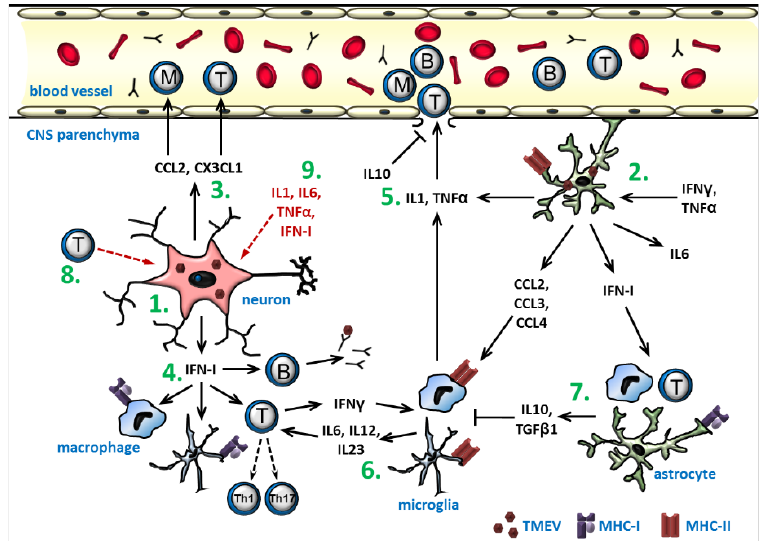
Figure 7. A schematic overview of the cytokine- and chemokine-mediated effects during early inflammation in a Theiler’s murine encephalomyelitis virus infection: ( 1 ) TMEV-infection of neurons results in the expression of chemokines and IFN-I. ( 2 ) Virus replication in astrocytes and their stimulation by IFNγ and TNFα also causes cytokine and chemokine production. ( 3 ) The chemokines CCL2 and CX3CL1 attract monocytes and lymphocytes. ( 4 ) IFN-I activates B cells, T cells, microglia, and macrophages and promotes antigen presentation. ( 5 ) IL1 and TNFα stimulate leukocyte extravasation, whereas IL10 stabilizes the blood–brain-barrier. ( 6 ) Macrophages and microglia activated by IFNγ and chemokines upregulate MHC class II and costimulatory molecules and secrete IL6, IL12, and IL23 to induce the differentiation of T cells into Th1 and Th17 cells, which have antiviral and pro-inflammatory properties. ( 7 ) The activation of macrophages and microglia is inhibited by the anti-inflammatory cytokines IL10 and TGFβ1, which the production of can also be induced by IFN-I. ( 8 ) The virus elimination is partly dependent on the activated cytotoxic T cells, which also cause neuronal necrosis and axonal injury. ( 9 ) Pro-inflammatory cytokines also have an ictogenic effect on neurons, predisposing to seizure development. The scheme summarizes the main results of multiple studies and does not include all the interactions demonstrated so far.